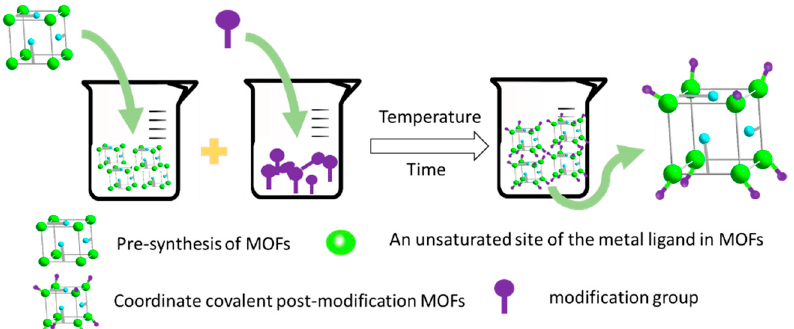
Figure 7. Schematic diagram for the coordinate covalent post-synthetic modification of MOFs.